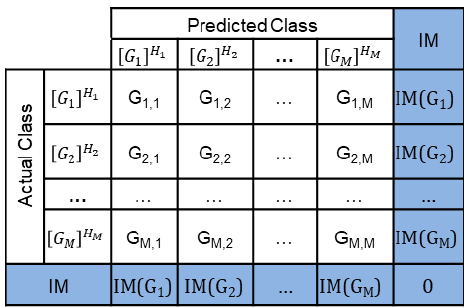
Figure 4. The reduced confusion matrix “ M × M + IM ” format ( H = R , S , RS